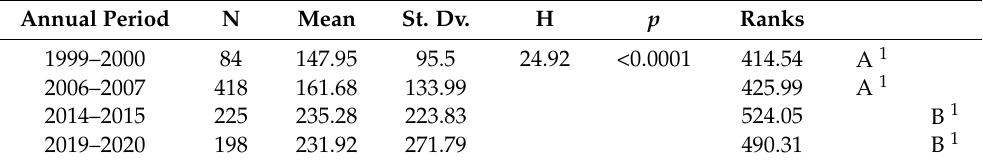
Table A5. Euclidean Distance’s Kruskal Wallis tests between time periods.